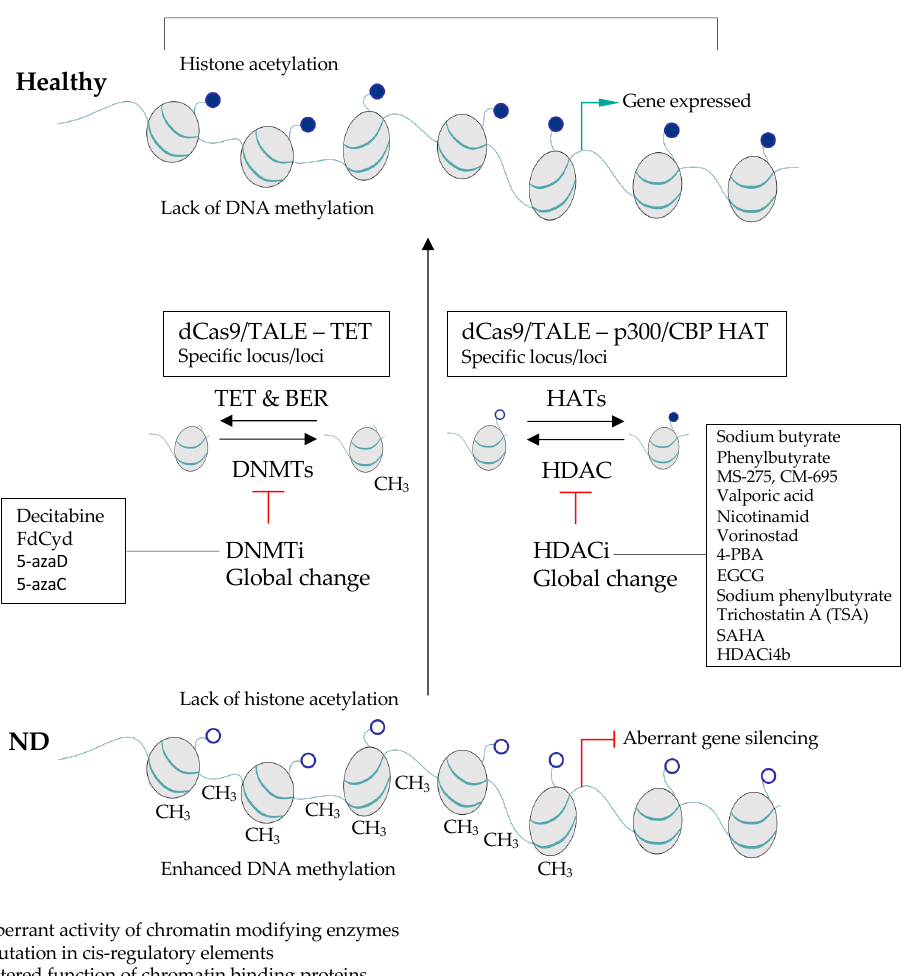
Figure 3. NDs frequently feature altered chromatin landscape including promoter silencing and gene repression. Global or locus-specific approaches can be envisioned to restore proper gene activity. Epidrugs, including histone deacetylase inhibitors (HDACi) or DNA methyltransferase inhibitors (DNMTi), exert a global impact on chromatin and can help reactivate a proportion of aberrantly silenced genes. Designer nuclease-based systems (TALEs and CRISPR-Cas9-based) modify chromatin structure locally and specifically impacting by and large only the chosen loci. Designer nuclease-based systems display minimal off-target effects and potentially extremely low